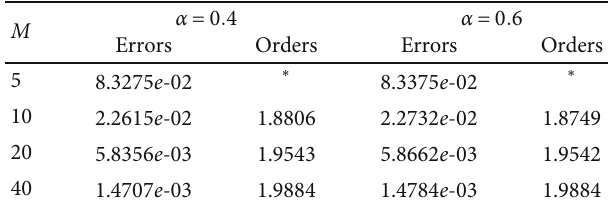
Table 4: The errors and orders in temporal and spatial direction by using L-FEM.